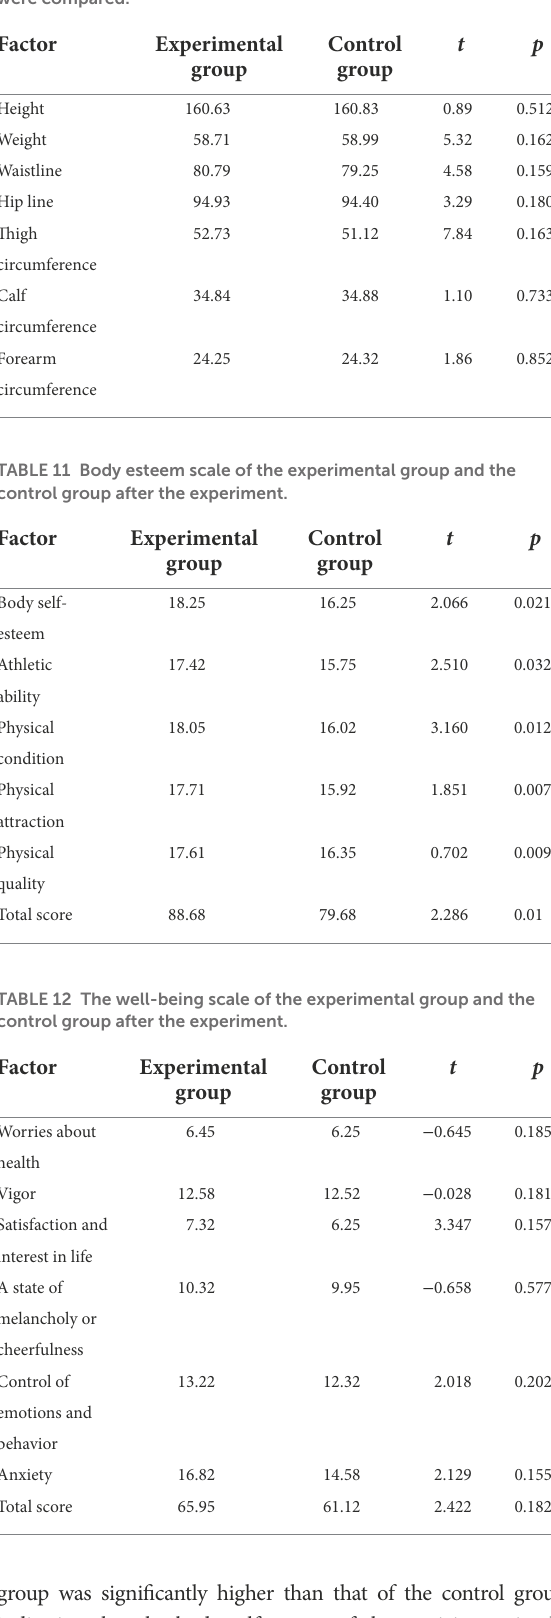
TABLE 10 After the experiment, the physical characteristics of the silver-haired people in the experimental group and the control group were compared.